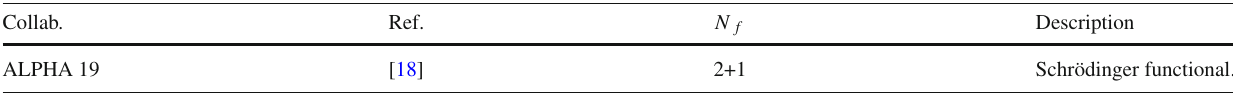
Table 86 Renormalization in determinations of m ud , m s and, in some cases m u and m d , with N f = 2 + 1 quark flavours Collab.